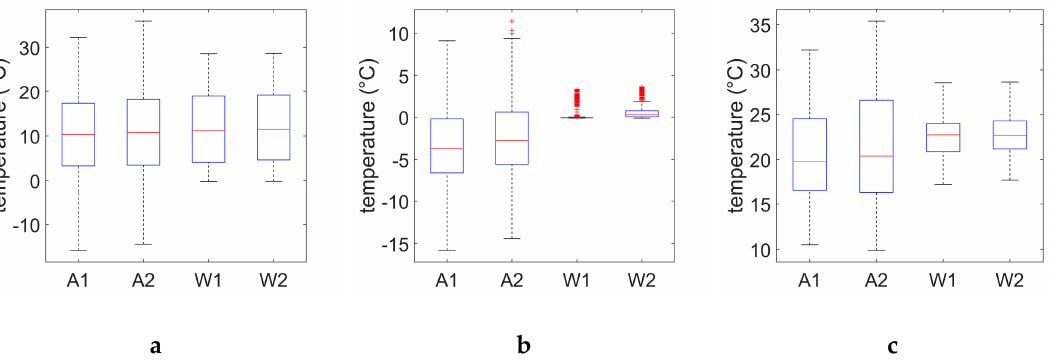
Figure 6. Boxplots of water and air temperature time series (hourly data) for the following time intervals (the red line represents the median): ( a ) year 2019, ( b ) January 2019, ( c ) August 2019 (A1—Suceava Weather Station, A2—Suceava city in the floodplain, W1—Suceava River upstream, W2—Suceava River downstream).